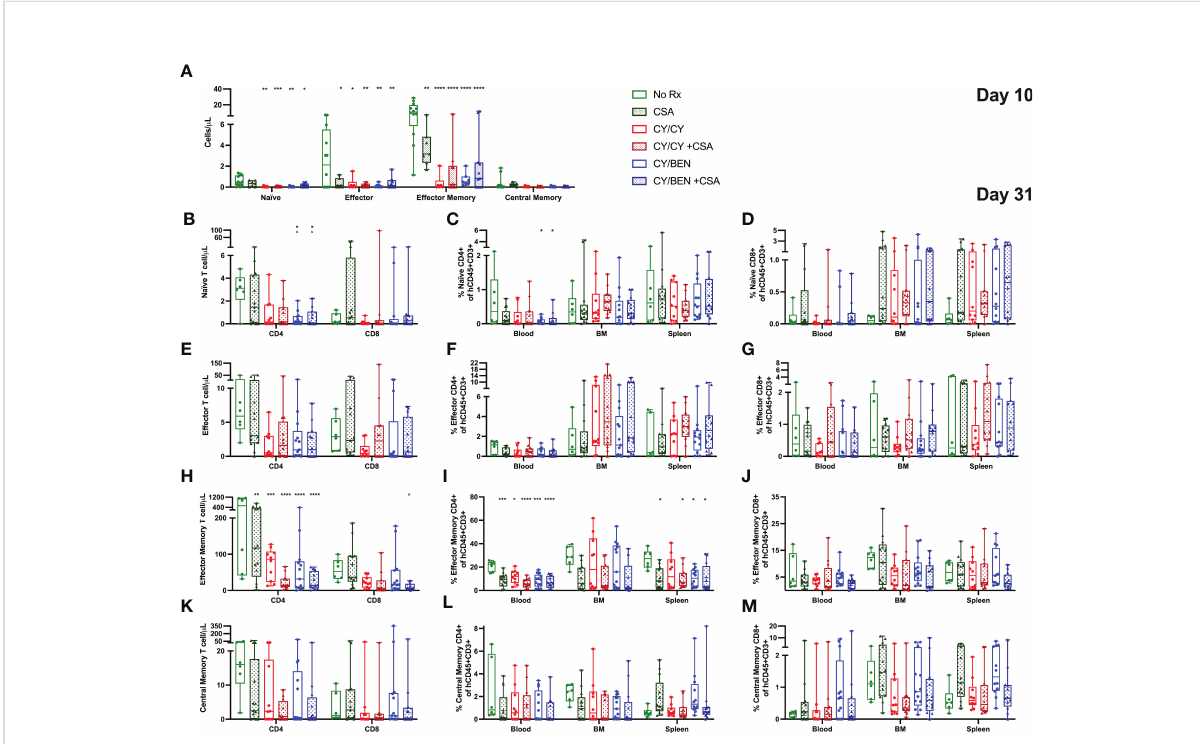
FIGURE 6 Post-PBMC infusion CY/BEN with or without CSA signi fi cantly reduces the absolute counts and frequencies of naïve and effector memory T cells at days 10 and 31. Blood, bone marrow and/or spleens were collected from animals at days 10 and 31 post-PBMC infusion and prepared for fl ow cytometric analysis as described in Materials and Methods. (A) Absolute counts of circulating effector T cell subsets at day 10, gated as described below. (B-M) Day 31 frequencies and counts of effector T cell subsets. All subsets were gated from CD45+CD3+ cells (B-D) Naïve T cells were gated as CCR7+CD62L+CD45RA+. (E-G) Effector T cells were gated as CCR7-CD62L-CD45RA+. (H-J) Effector Memory cells were gated as CCR7-CD62L-CD45RO+. (K-M) Central Memory T cells were gated as CCR7+CD62L+CD45RO+. (A-M) Signi fi cant differences across treatment groups were determined via a one-way ANOVA followed by Tukey ’ s post-hoc comparisons. P values are indicated by the number of symbols on graphs, *<0.05, **<0.01, ***<0.001, ****<0.0001. Asterisks (*) mark signi fi cant differences from vehicle group, arrows (^) mark differences from CSA